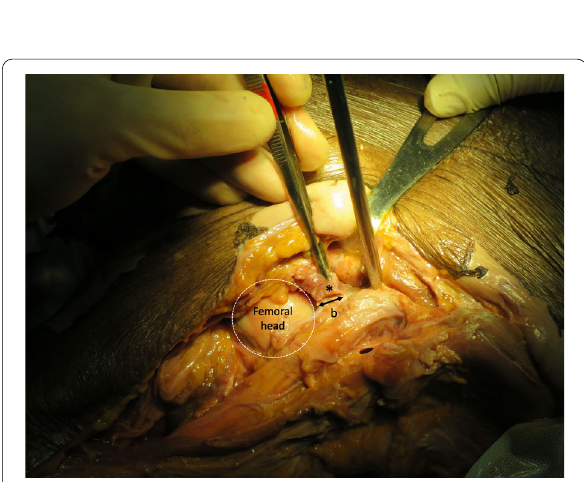
Fig. 6 The hip capsule is identified ( asterisk ) distal to the pin insertion site on the left hemipelvis, and the distance ( b ) from the acetabulum edge to the insertion of the hip capsule